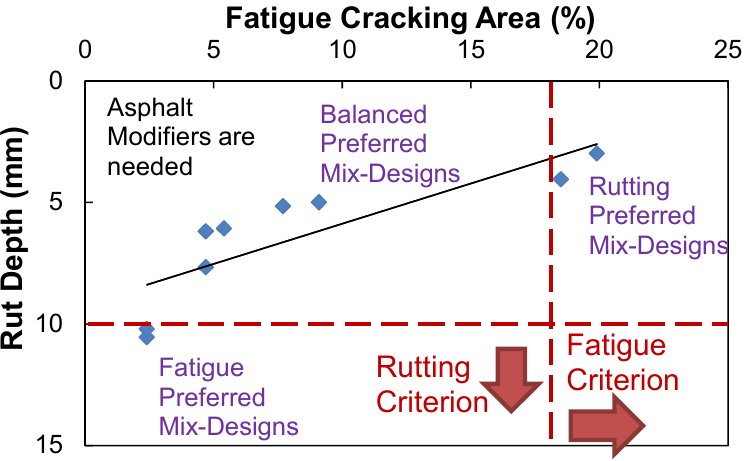
Figure 11. Fatigue and rutting performance cross-plot of the ALF mix designs.